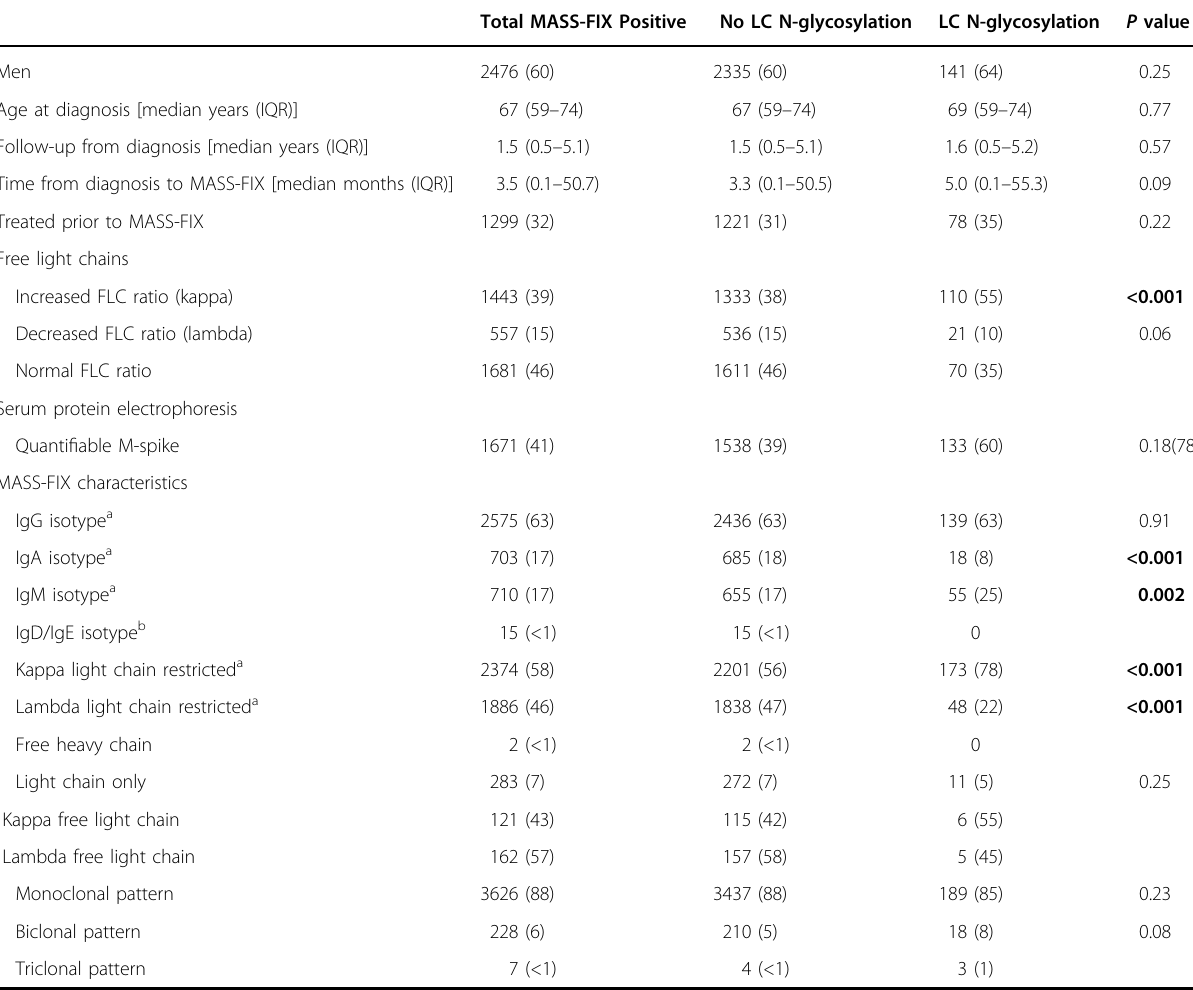
Table 1 Demographic and laboratory characteristics of 4118 MASS-FIX positive patients, strati fi ed by non-LC N-glycosylated (3897) and LC N-glycosylated (221)